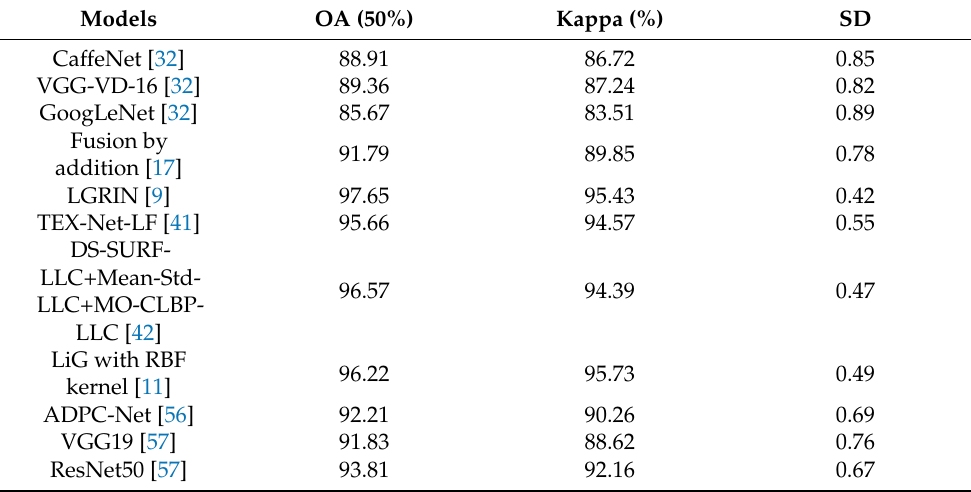
Table 4. Overall accuracies (%), Kappa coefficient and the standard deviation of twenty-six kinds of methods and our method under the training ratios of 50% in